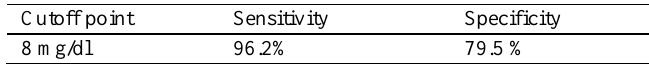
Figure (4 ): ROC curve for transcutaneous forehead bilirubin values predicting TSB value >10mg/dl (area under the curve AUC=0.973) Table (10): Coordinates of the Curve of transcutaneous forehead bilirubin regarding